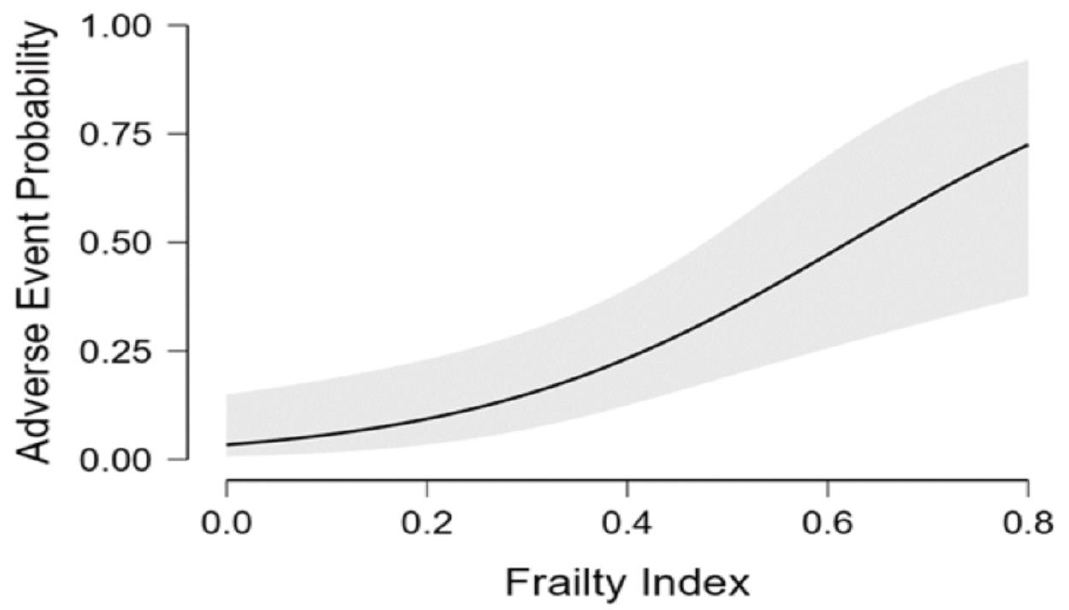
Figure 2. Regression analysis inferential plot. Relationship between baseline frailty index score and odds of serious adverse event requiring re-hospitalization. odds of serious adverse event requiring